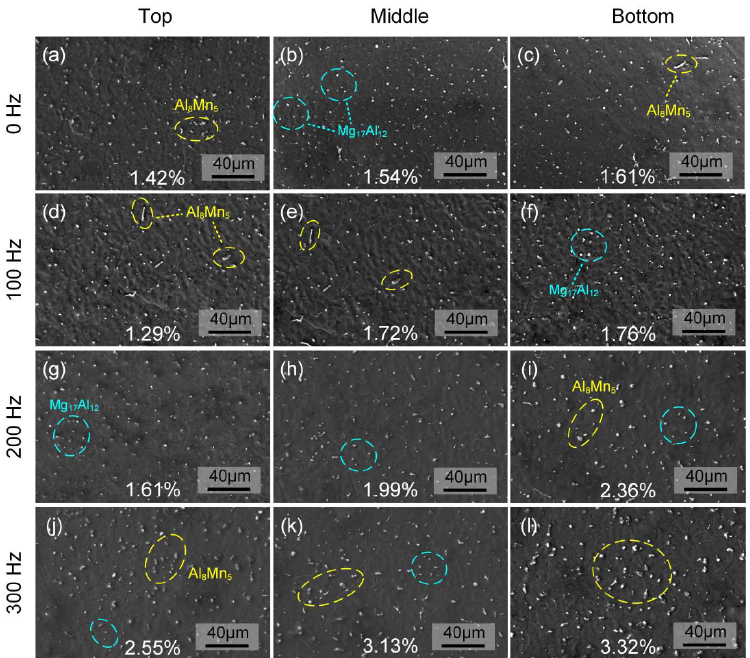
Figure 7. SEM-SE micrographs of precipitates at various positions from 0 Hz to 300 Hz. ( a – c ) 0 Hz; ( d – f ) 100 Hz; ( g – i ) 200 Hz; ( j – l ) 300 Hz.